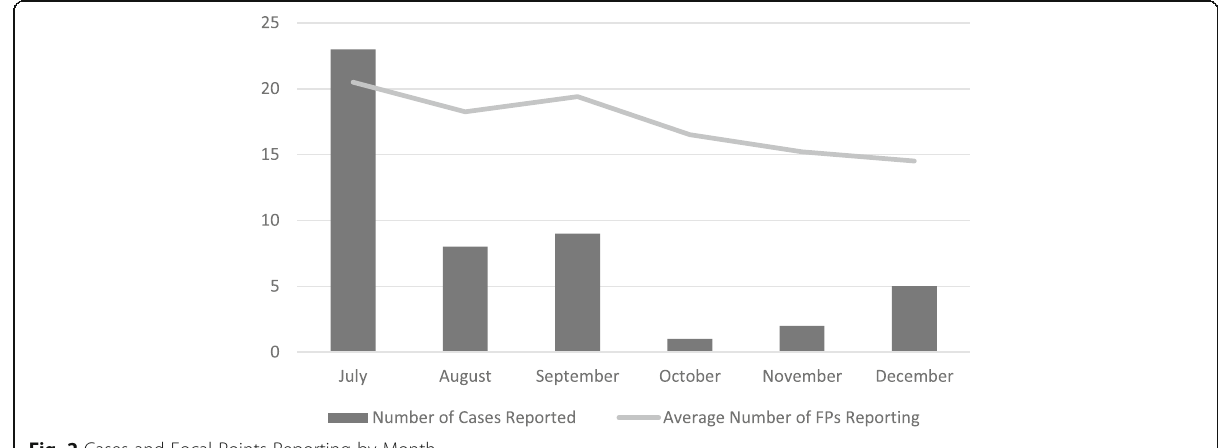
Fig. 2 Cases and Focal Points Reporting by